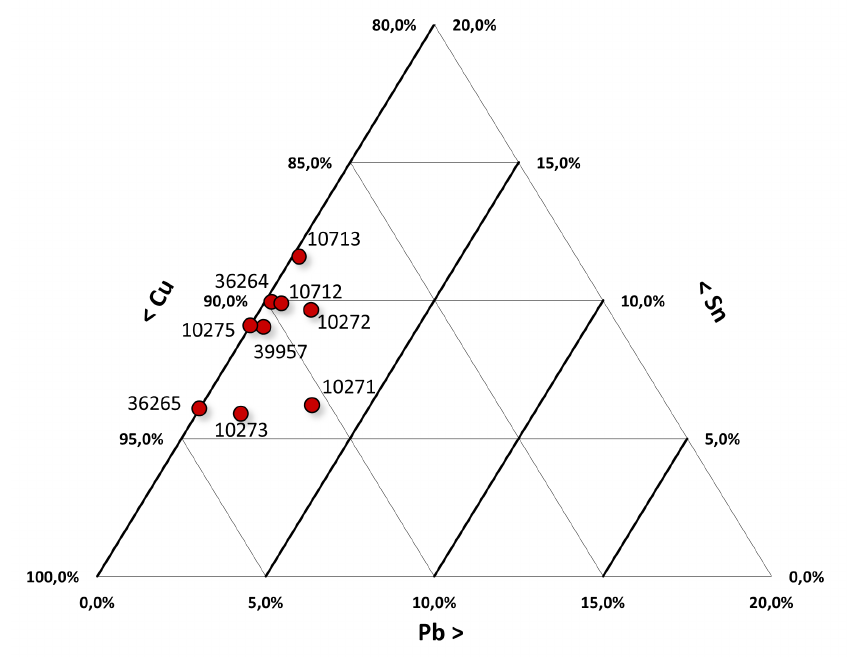
Figure 4. Ternary diagram for Cu-Sn-Pb of the composition of the